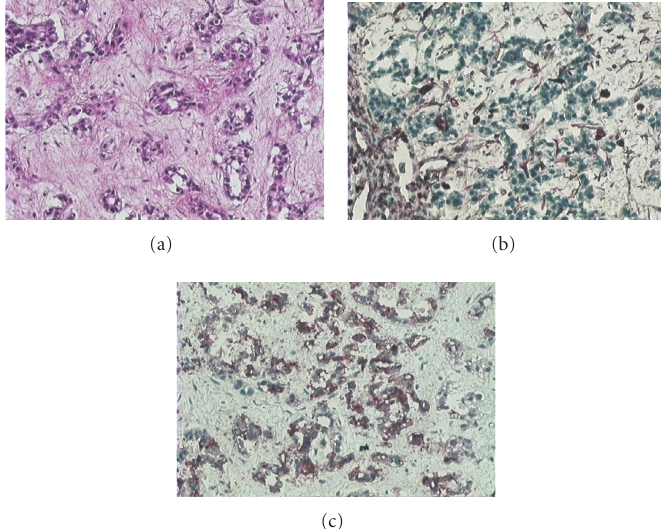
Figure 4: (a) Histopathologic examination revealed pathognomonic features of a hemangioendothelioma, showing that the tumour was mainly composed of epithelioid cells which form primitive vascular channels. Some cells even showed evocating intracytoplasmic vacuoles. (b, c) Immunohistochemical stains for factor CD 34 and vimentin displayed positive